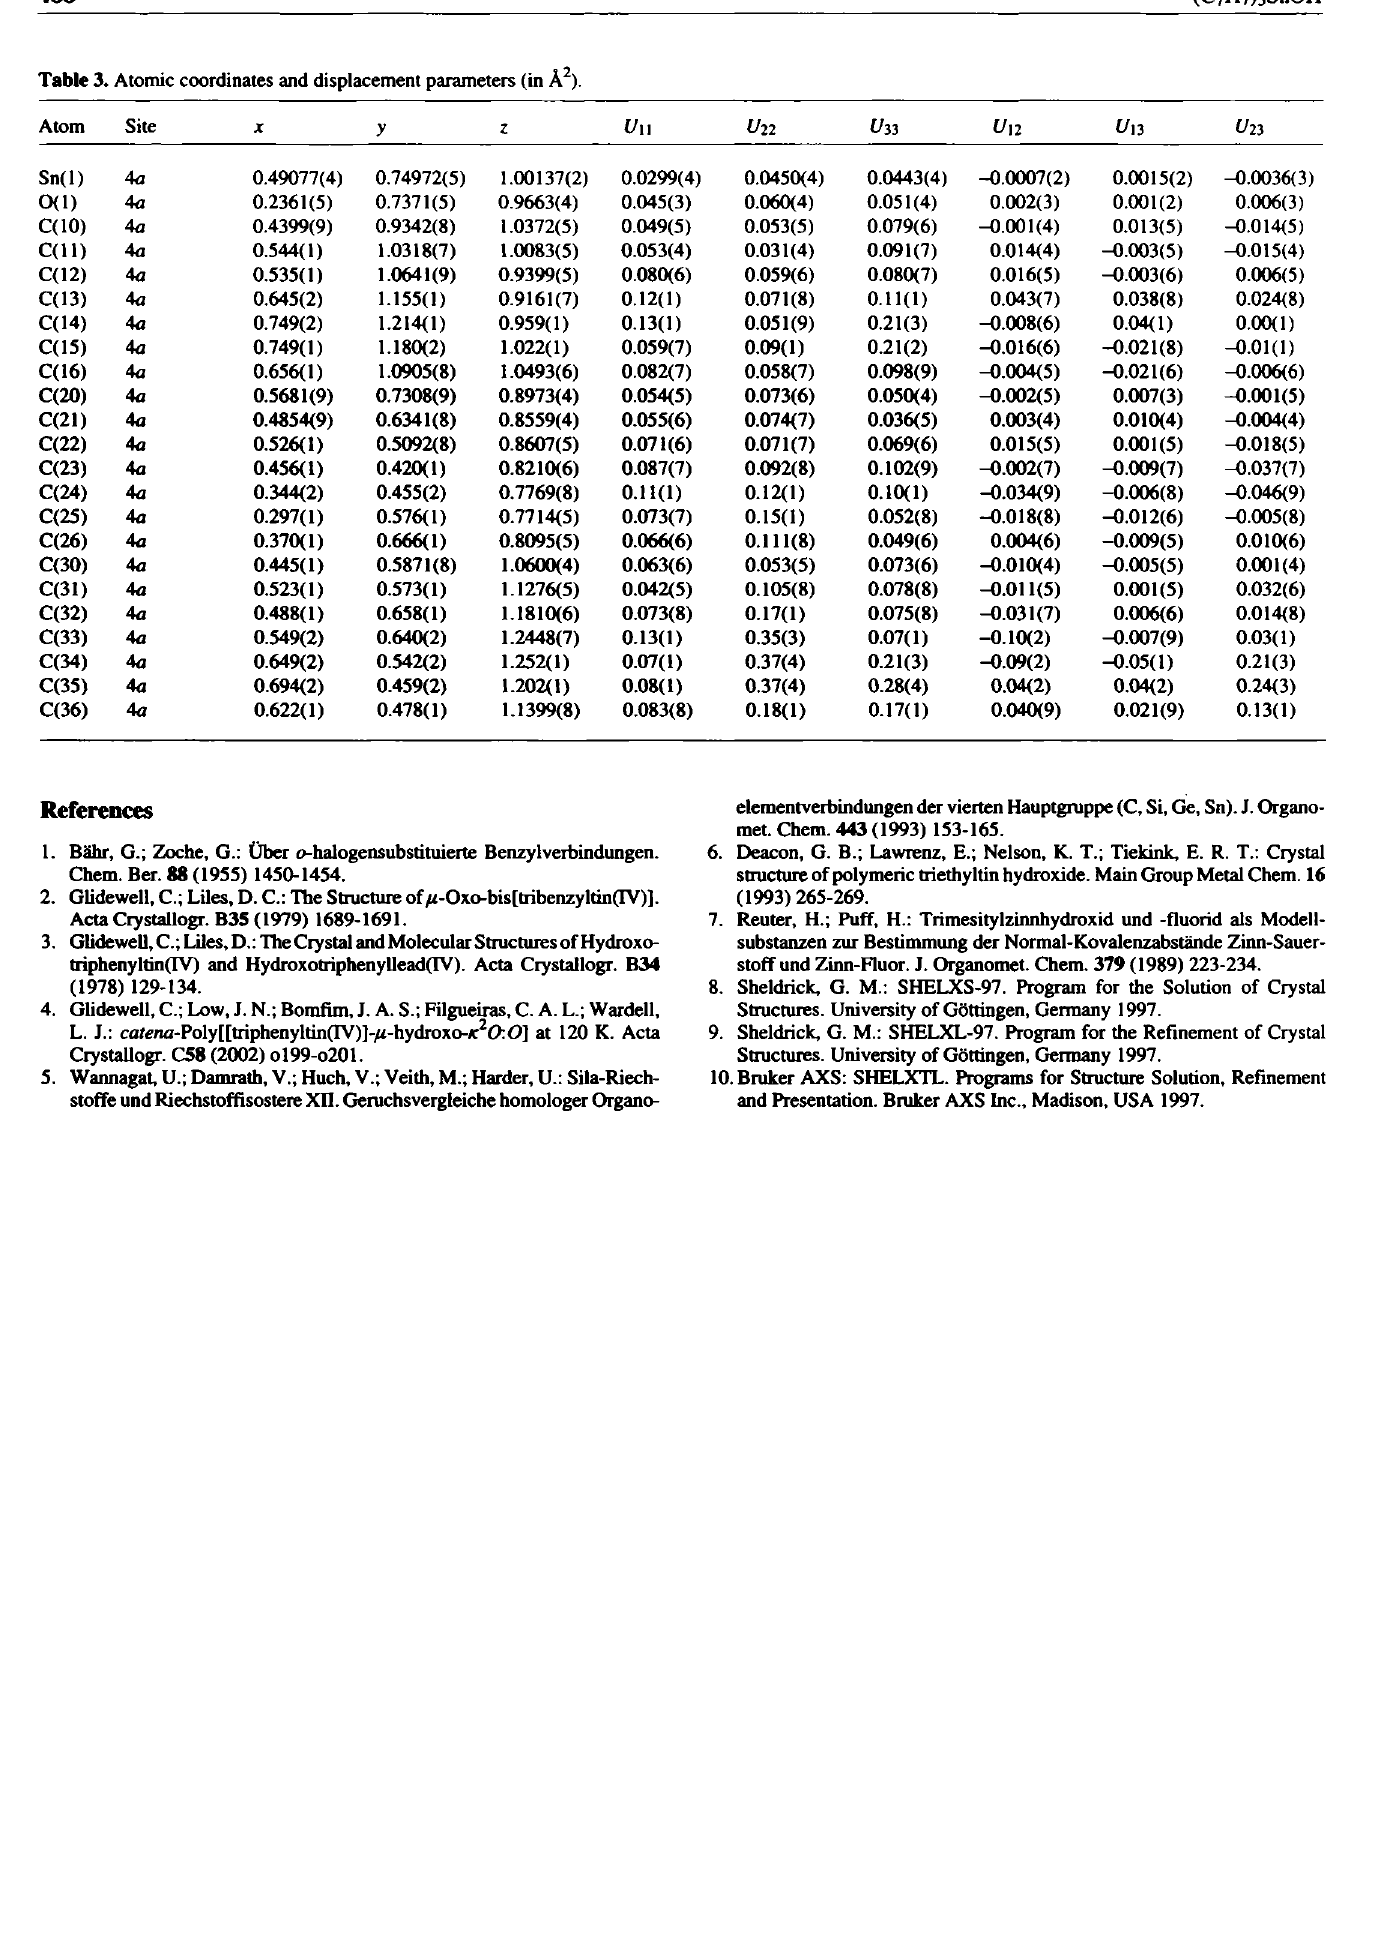
Table 3. Atomic coordinates and displacement parameters (in Â 2